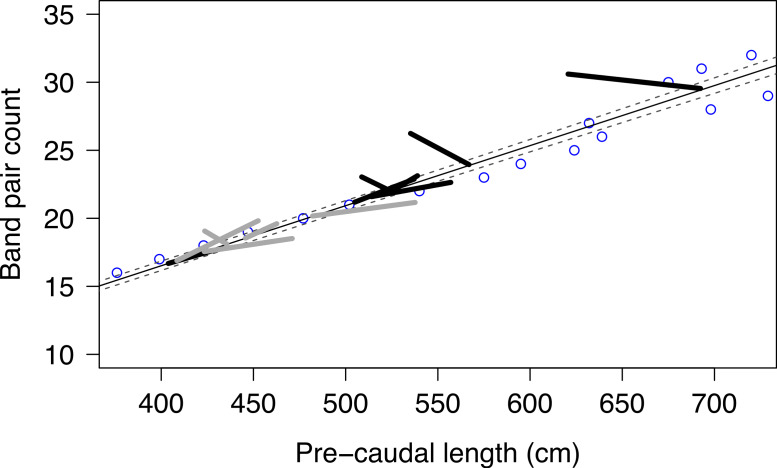
Growth increments.Observed growth increments of male (black) and female (grey) whale sharks plotted as size at age based on back-calculated lengths from vertebral band pair counts (Wintner, 2000) with 95% CI indicated by dashed lines. The initial size measurement was placed on the PCL/band pair count regression (dark line).